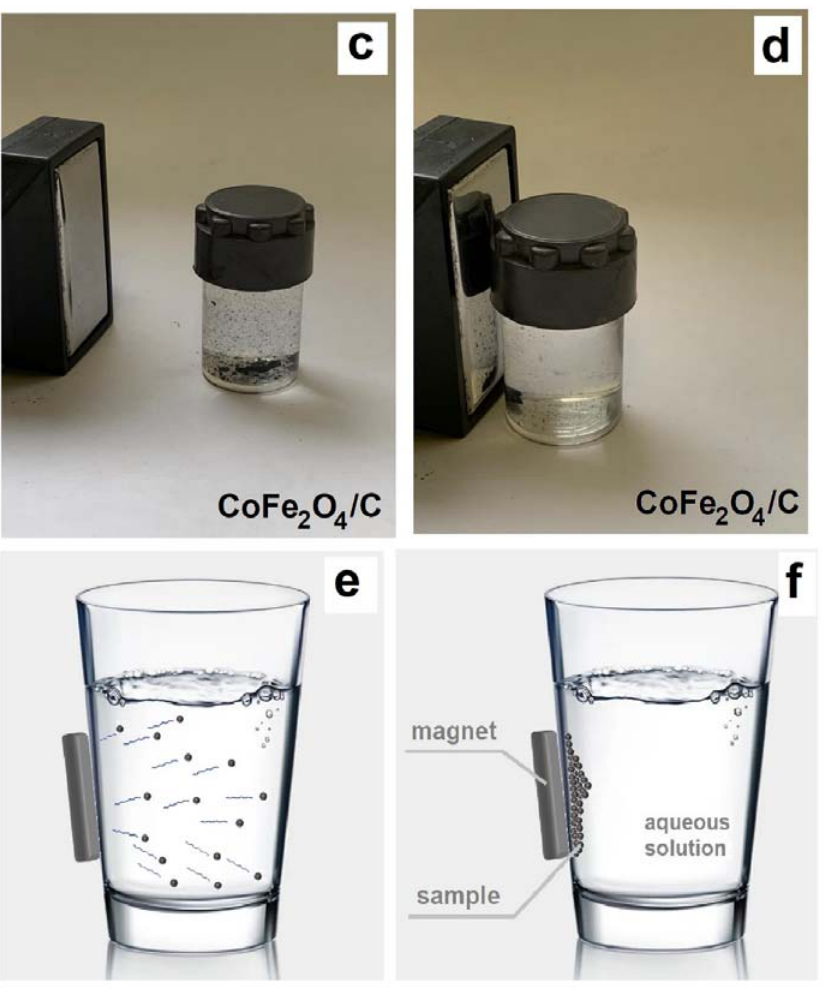
Figure 7. Magnetic separation of synthesized material: composites ( a – d ), schematic representation ( e , f ).